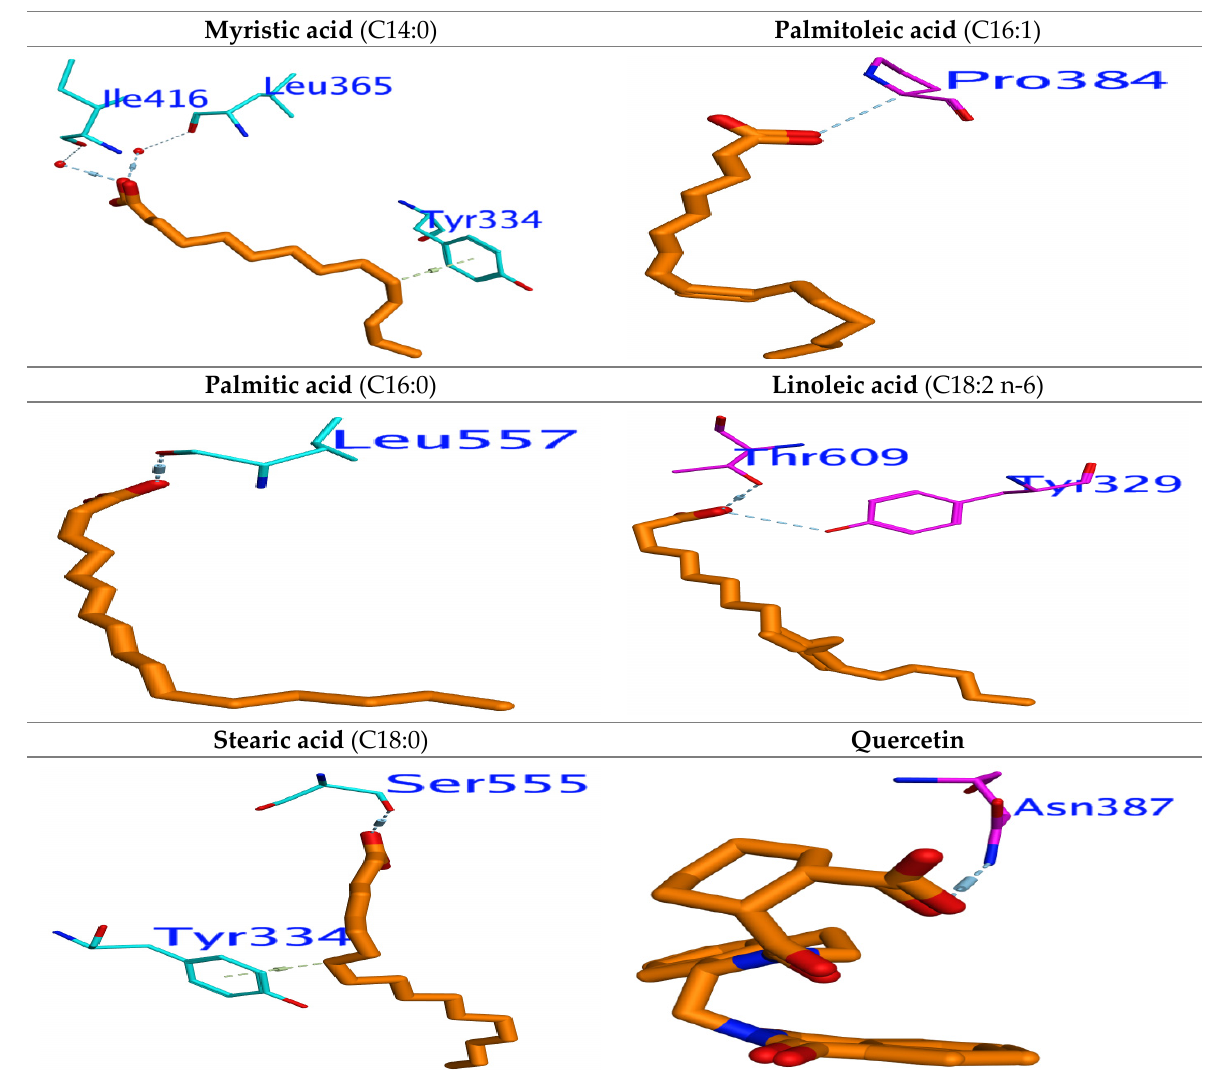
Figure 12. Docking of AO and HERA into (PDB code: 4L7B). H-Bond is characterized by blue lines, hydrophobic interactions are presented by green dotted lines.